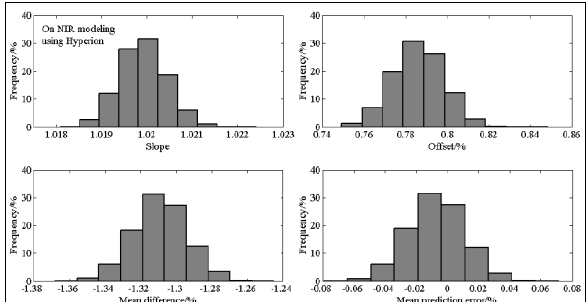
Figure 5. Uncertainty of the linear transformation model for NIR (785–900 nm), based on the ASTER spectra collection. In this figure, “Mean difference” is the original difference between testing pairs without/before transformation and “Mean prediction error” is the difference after modelling transformation. The statistics are based on 10,000 times K-fold cross-validation (K=5).